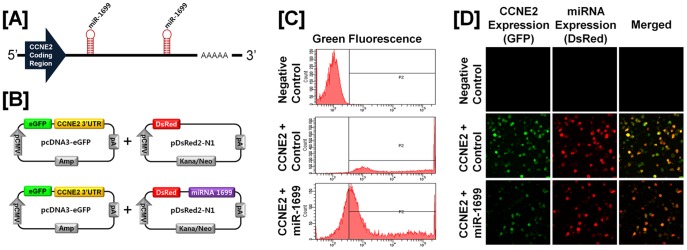

In vitro target assay for microRNAs on the CCNE2 transcript.[A] Diagram of miR-1699 binding sites in the 3′-UTR of the CCNE2 gene. [B] Expression vector maps for eGFP within the 3′-UTR of the CCNE2 gene and Ds-Red within each miRNA. The 3′-UTR of the CCNE2 transcript was subcloned between the eGFP gene and the polyA tail to generate the fusion construct of the GFP transcript following the miRNA target 3′-UTR (pcDNA-eGFP-3′UTR) (upper panel) and the miRNA expression vector was designed to co-express DsRed and each miRNA (pcDNA-DsRed-miRNA) (lower panel). [C and D] After co-transfection of pcDNA-eGFP-3′UTR for the CCNE2 transcript and pcDNA-DsRed-miRNA for the miR-1699, the fluorescence signals of GFP and DsRed were detected using FACS [C] and fluorescent microscopy [D]. See Materials and Methods for complete description.